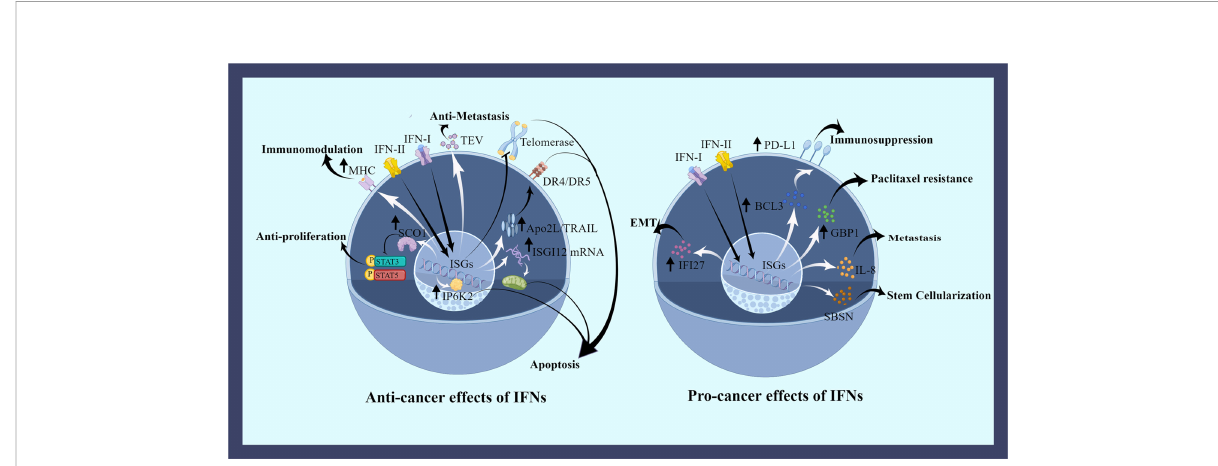
FIGURE 2 The effects of IFNs on ovarian cancer cells. IFNs have both favorable and unfavorable roles in OC cells. IFNs regulate OC cells by promoting the expression of some proteins or inhibiting some pathways. IFNs induce apoptotic effects in the nucleus, mitochondria, and cell membrane. Cell cycle is dysregulated by disrupting phosphorylation. The uptake of regulated tumor extracellular vesicles (TEVs) is inhibited by IFNs counteracting metastasis. And IFNs promote the expression of tumor antigens to aid immune killing. Many negative effects of the elevated protein expression caused by IFNs have been demonstrated, including OC cells metastasis, drug resistance, stemness, epithelial mesenchymal transition (EMT), and immunosuppression. This picture is drawn with the help of